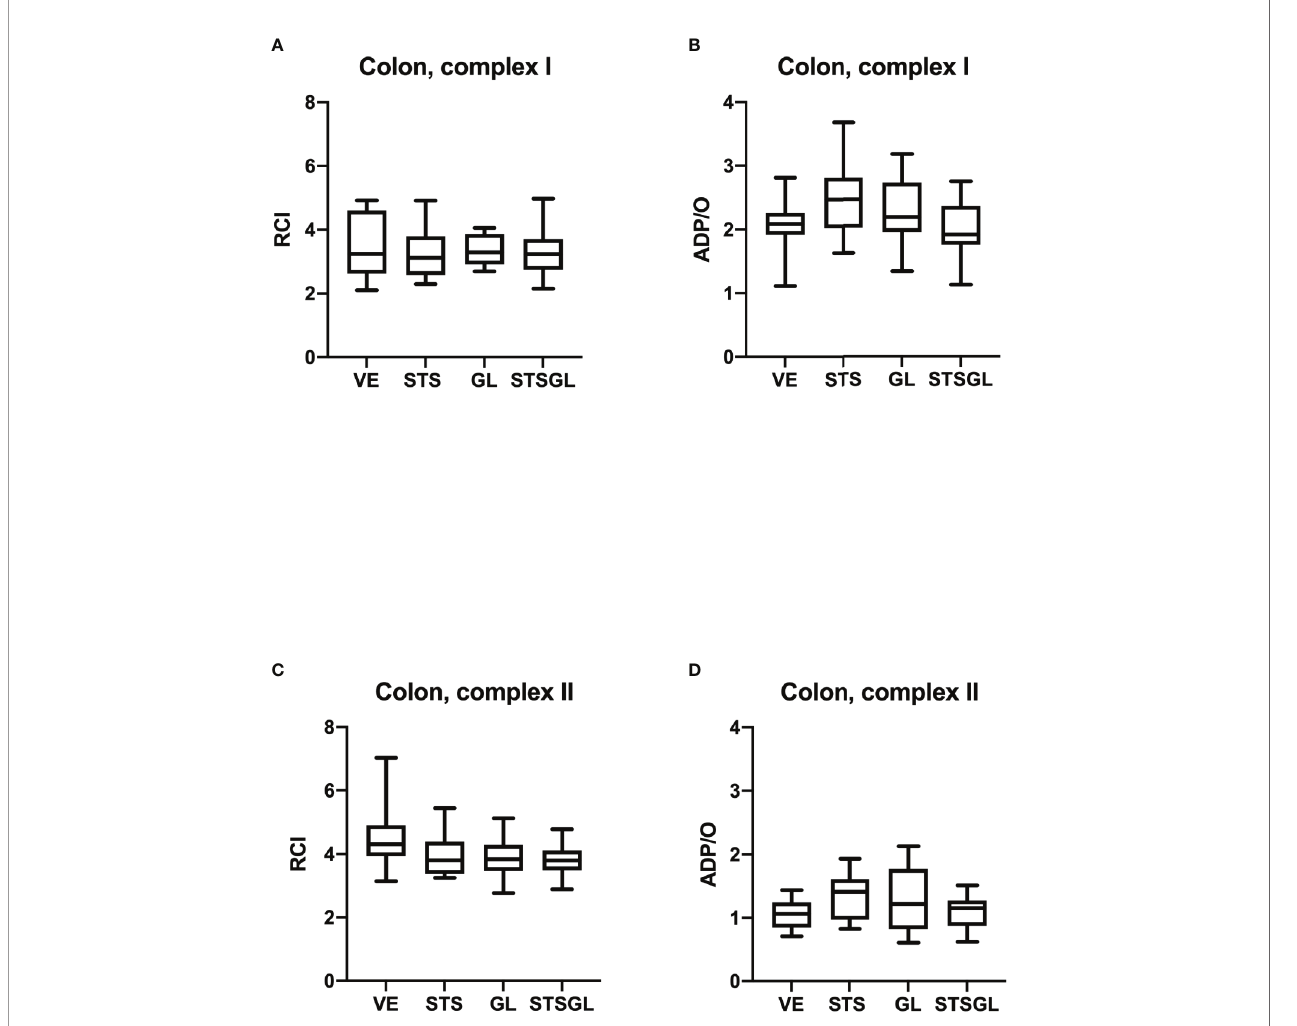
FIGURE 4 | Intestinal mitochondrial function in septic animals. Effect of sodium thiosulfate (STS), glibenclamide (GL) and sodium thiosulfate/glibenclamide (STSGL) compared to control (vehicle: VE) on mitochondrial function of colonic tissue homogenates from septic rats: respiratory control index (RCI) for complex I (A) and complex II (C) and ADP/ratio for complex I (B) and complex II (D) . Data are presented as Box-Whisker-Plots presenting median, interquartile range, minimum and maximum value,